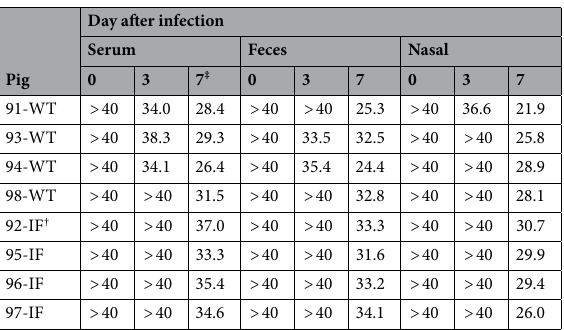
Table 2. A qRT-PCR results for fecal-nasal swabs from the second SVA challenge. PCR results are presented as Ct values. † IF: Piglets homozygous for the in-frame mutation shown in Fig. 5. ‡ Ct values for Day 7 Serum were statistically different between WT and IF pigs ( P =